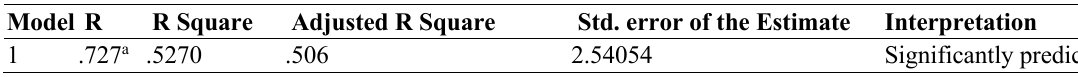
Table 2: Model summary Model R R Square Adjusted R Square Std. error of the Estimate